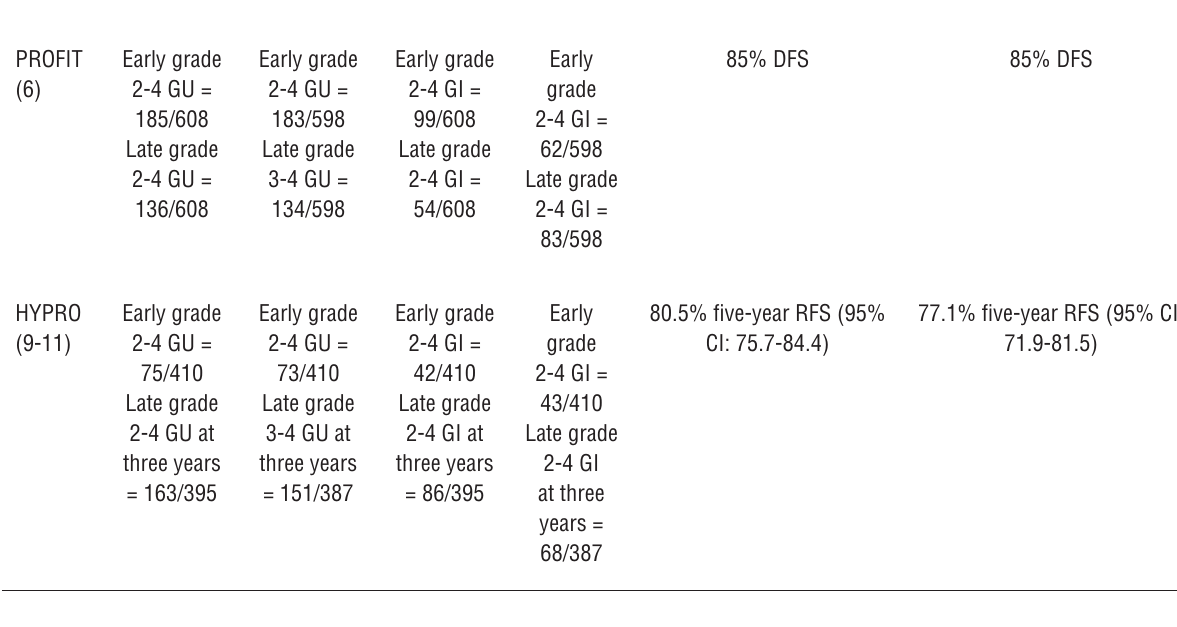
Figure 1 - Default External Beam Radiation Therapy Fractionation used by North American genitourinary oncology expert radiation oncologists for treatment of a hypothetical patient with a favorable intermediate risk Prostate Cancer (Gleason 3+4).